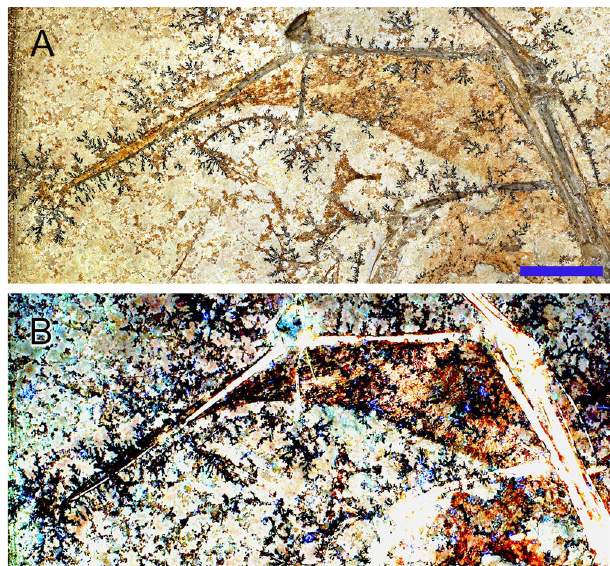
Figure 2. Left wing of aurorazhdarchid pterosaur specimen MB.R.3531a. ( A ) White light image. Scale = 15 mm. ( B ) LSF image defines details of the actinofibril complex and leading edge of the wing. Brown coloured portions of the anterior part of the wing appear to be preserved remnants of the retrophalangeal wedge.